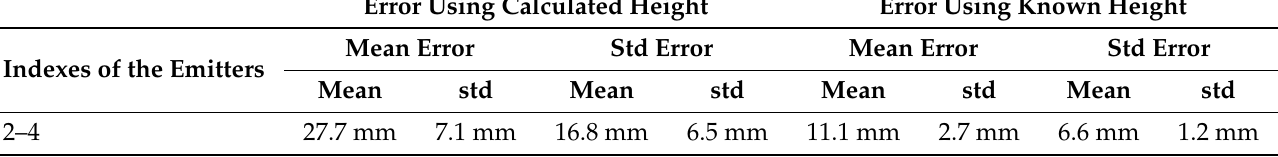
Table 7. Mean and error of the 44 receiver positions using calculated and known height and nine calibration points in the case